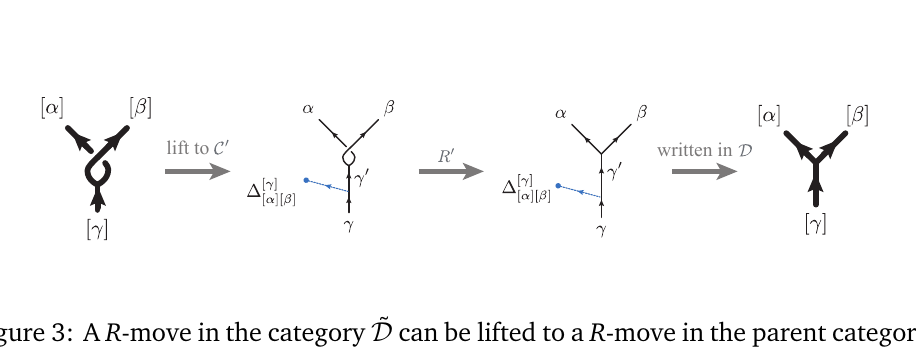
Figure 3: A R -move in the category ˜ D can be lifted to a R -move in the parent category C